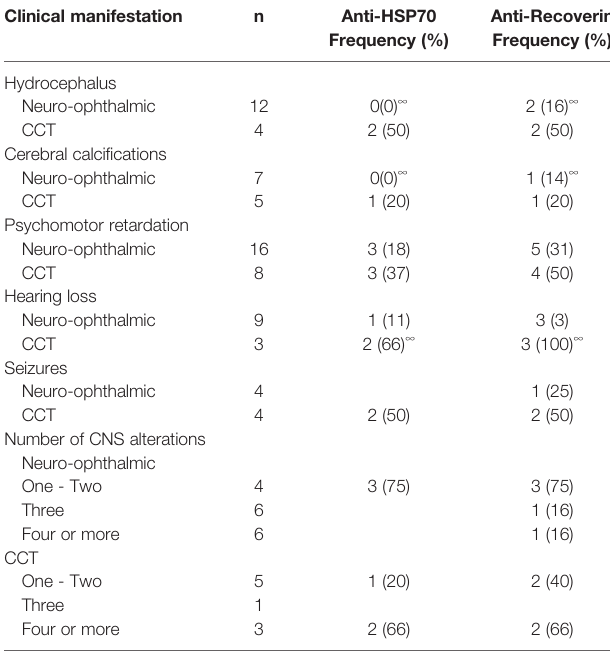
∞ Mann-Whitney-U (p < 0.05). Neuro-opthalmic group n =16. Congenital Cerebral Toxoplasmosis (CCT) group n =